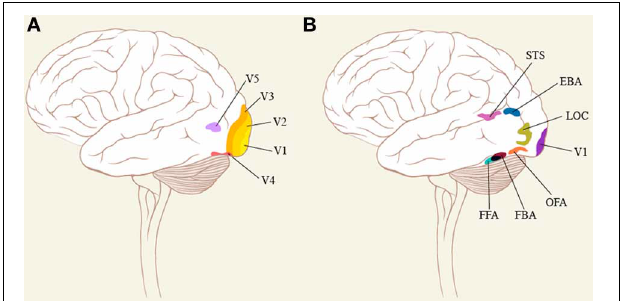
FIGURE 1 | (A) shows some of the classical visual areas on a surface drawing of the brain, while (B) shows the areas that are critical for face and body recognition. The position of these areas is